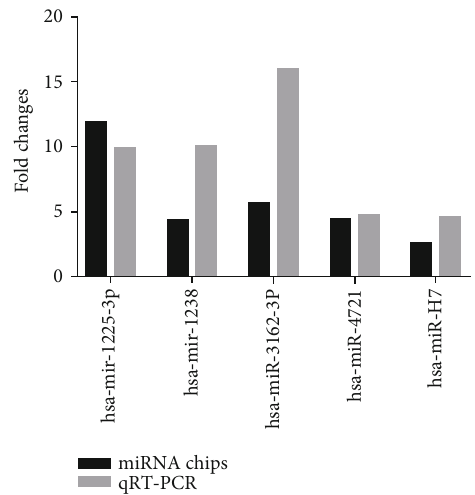
Figure 3: The fold changes of miRNA expression in the CHB nonsigni fi cant liver fi brosis group and signi fi cant liver fi brosis group and their comparison in miRNA chips.